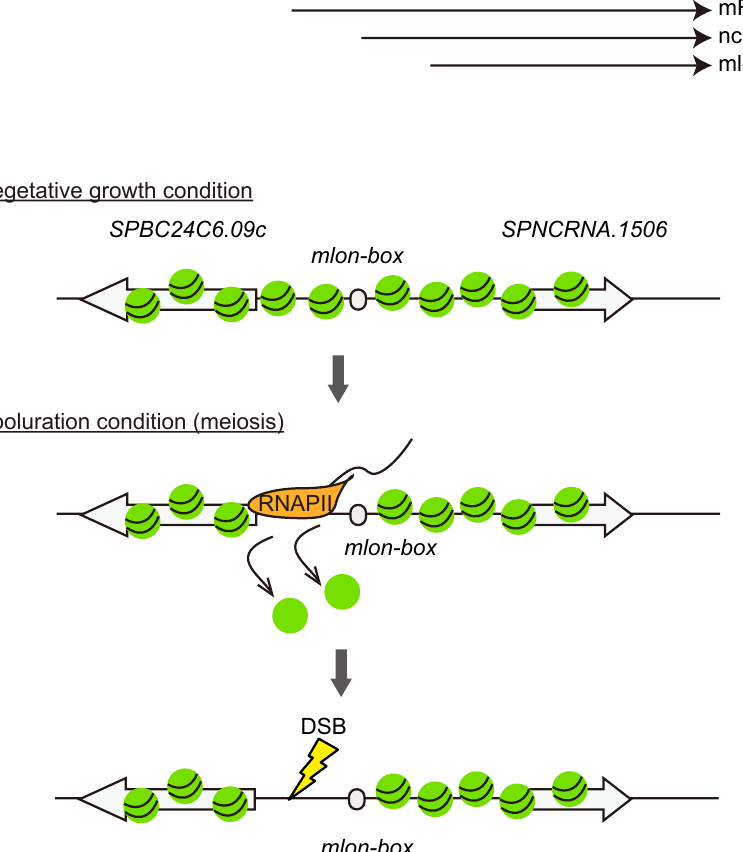
Figure 4. Mechanism of mlonRNA-transcription-induced meiotic recombination